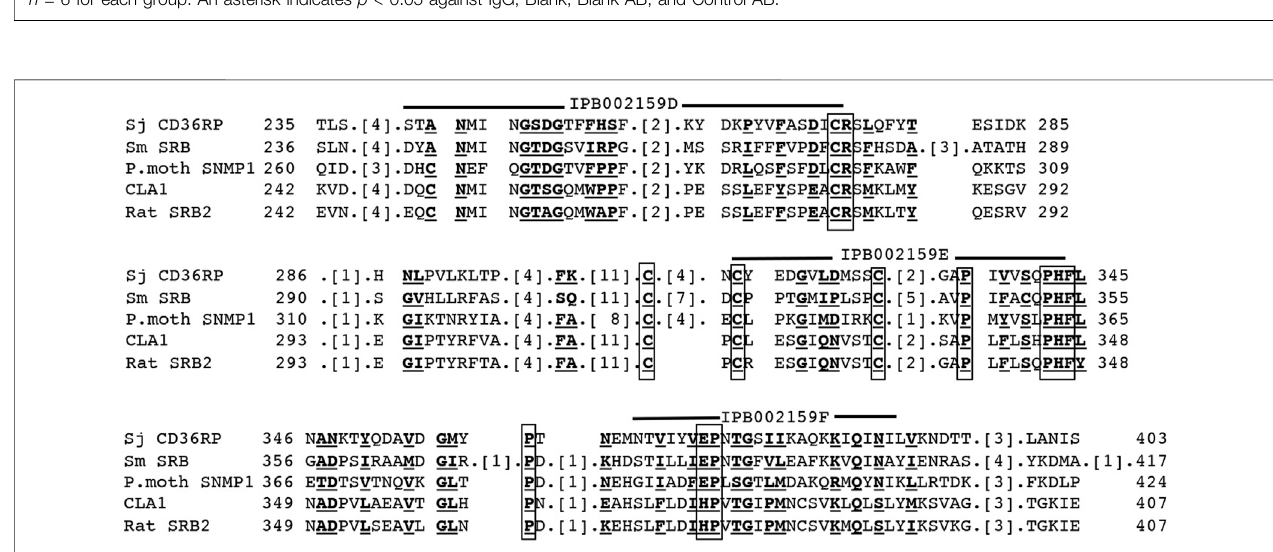
FIGURE4| Multi-alignmentoftheaminoacidsequencesofCD36RPof S.Japonicum (SjCD36RP)(Okumura-Nojietal.,2013)incomparisontootherCD36family proteins, S. mansoni scavenger receptor B (CD36-like protein) (Sm SRB) (Dinguirard and Yoshino, 2006), sensory neuron membrane protein of Polyphemus moth (P.moth SNMP-1), CLA1 as a human counterpart of SR-B1, and rat SR-B1. The amino acid residues in bald letters and underlined letters are conserved in 32 proteins from a variety of organisms. Conserved Cys and Pro residues in CD36 blocks IPB002159D to F regions are indicated as boxed.